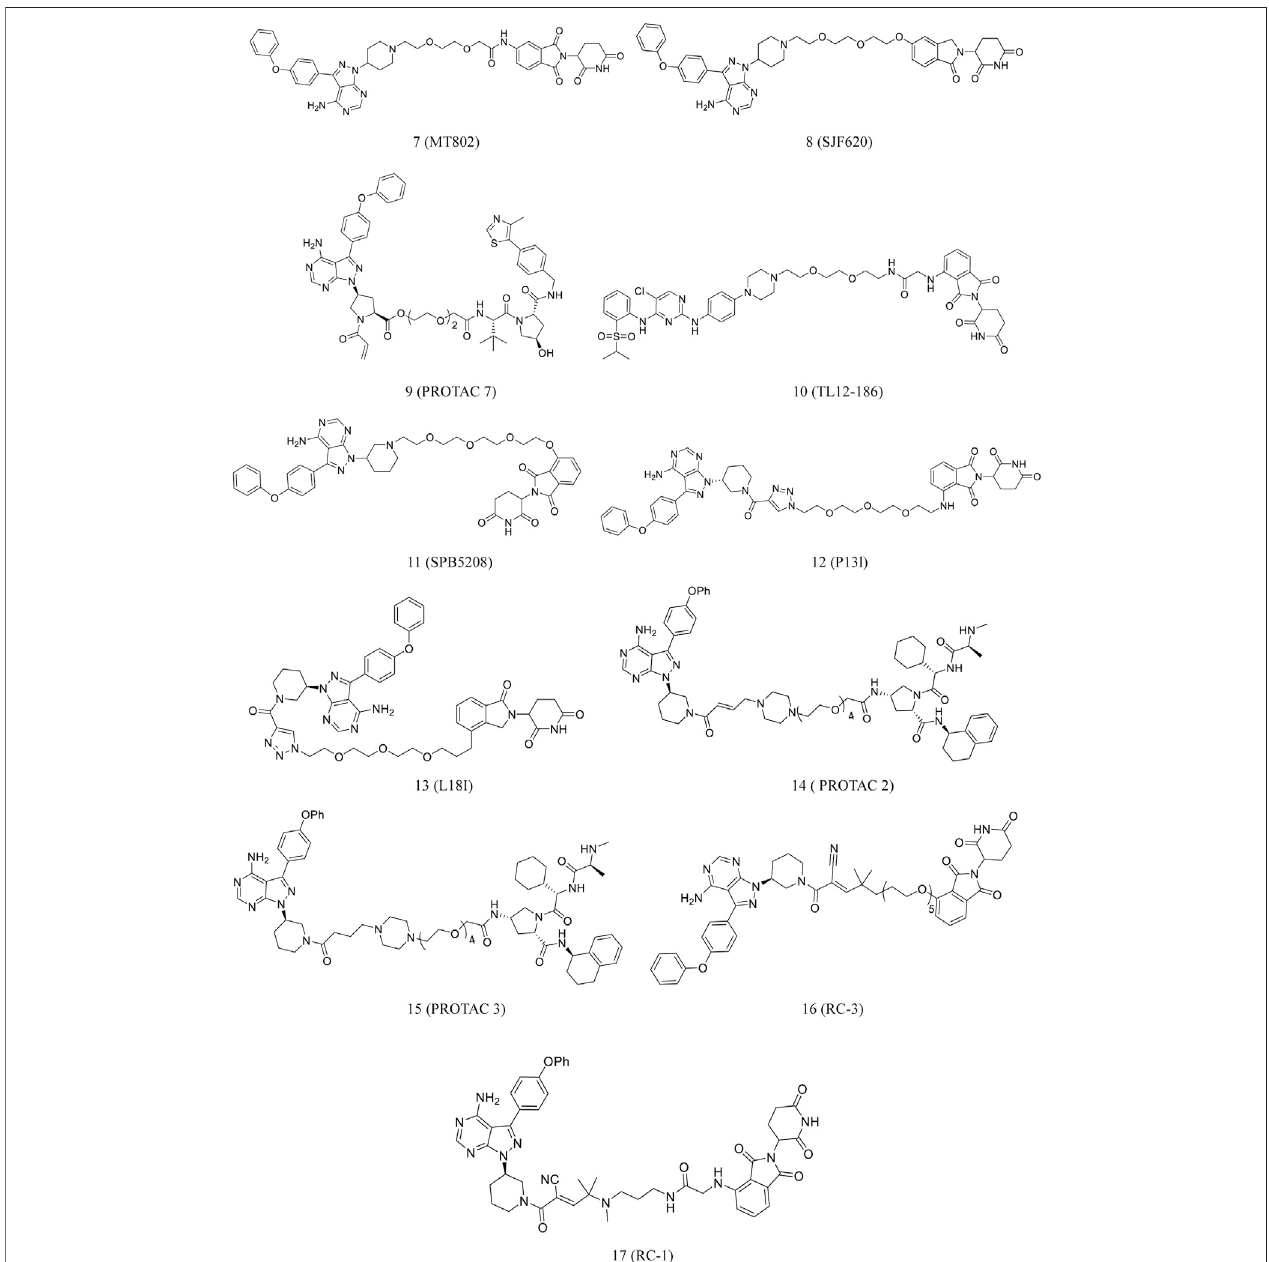
FIGURE 4 | Chemical structures of PROTACs targeting